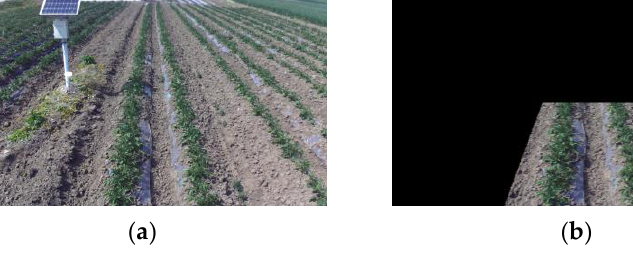
Figure 7. ROI settings: ( a ) original image; ( b ) ROI; ( c ) binary image mask.